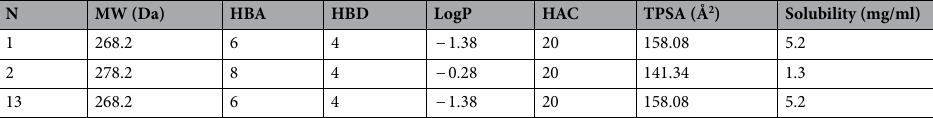
Table 4. Predicted physico-chemical properties of the best SapM inhibitors obtained from SwissADME 51 .